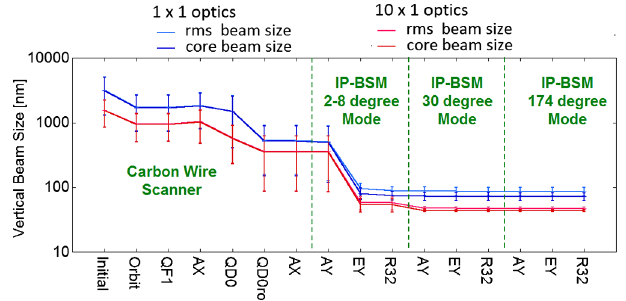
FIG. 8. Location of skew sextupole magnets (SK1-SK4). SK3 was installed in January 2011; the other SKs were installed in August 2012.